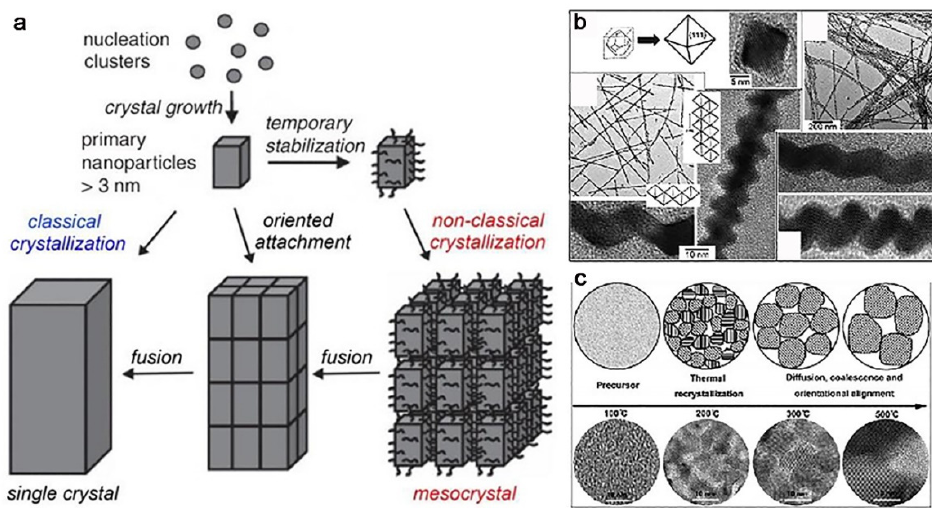
Figure 8. ( a ) Scheme of classical and non-classical crystallization. Reproduced with permission [105]. Copyright 2019, MDPI. ( b ) Octahedral PbSe nanocrystals grown in the presence of hexadecylamine (HDA) and oleic acid. TEM and HRTEM images of PbSe zigzag nanowires grown in the presence of HDA. Reproduced with permission [58]. Copyright 2005, American Chemical Society. ( c ) Scheme of structure and morphology transformation processes for the synthesis of Co 3 O 4 at different temperatures. Reproduced with permission [104]. Copyright 2013, Elsevier B.V.